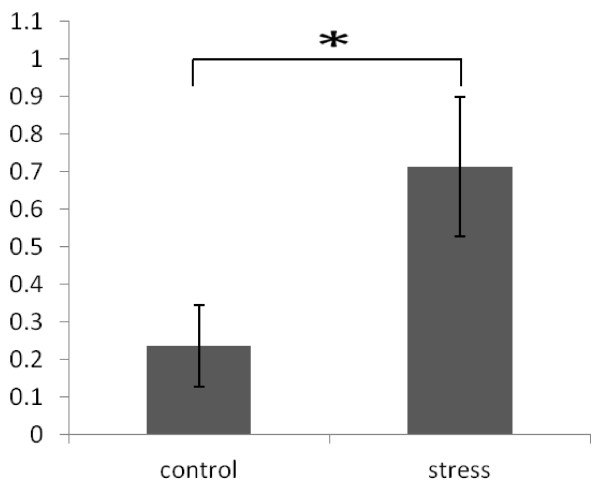
Expression ofbta-miR-497in control and stressed groups was measured by qRT-PCR and normalized toU6. The quantitative results are represented as mean ± SEM (n = 3). A single asterisk (P ≪0.05).